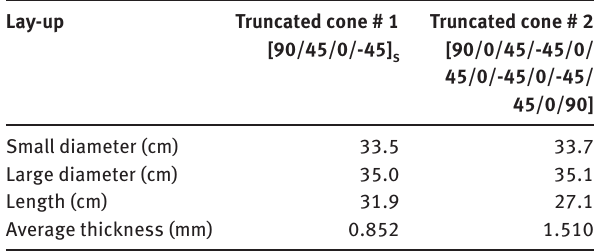
Table 5: Truncated cones geometric and lay-up specifications.